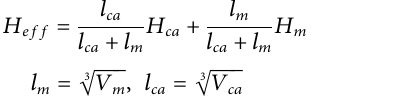
Frontiers in Materials |